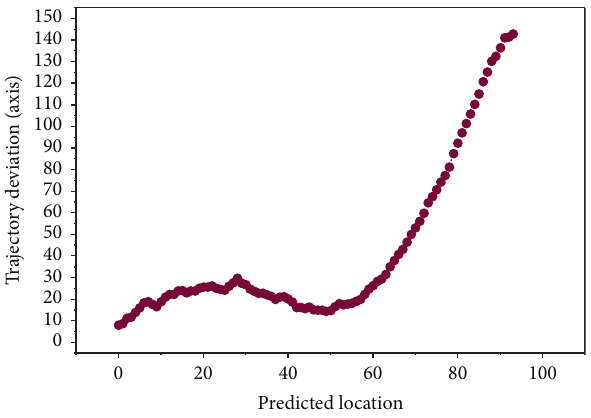
Figure 17: MAE scatter plot for left-turn trajectory